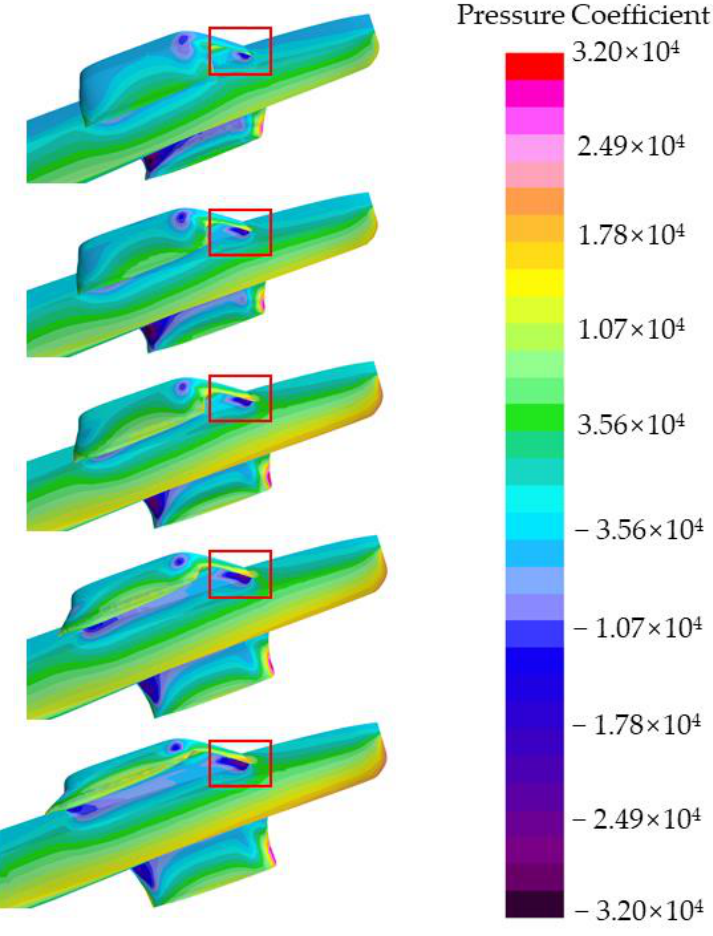
Figure 10. Hydrostatic hull outer surface pressure coefficient when Fr = 0.5.